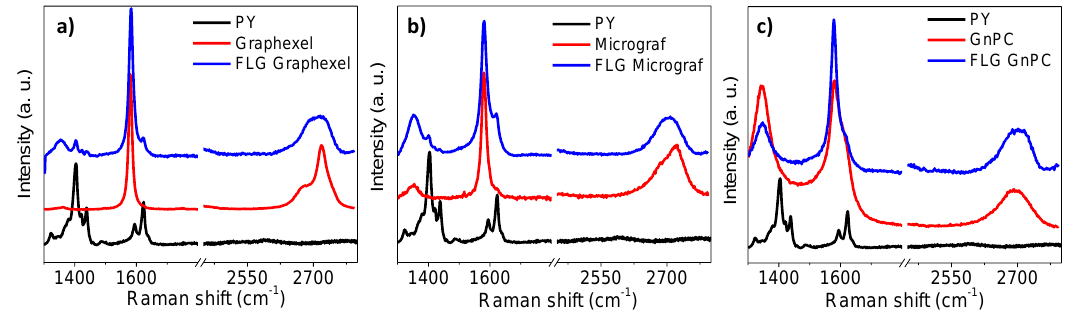
Figure 3. ( a – c ) Raman spectra of the Graphexel, Micrograf, and GnPC starting materials and its correspondent FLG, respectively.